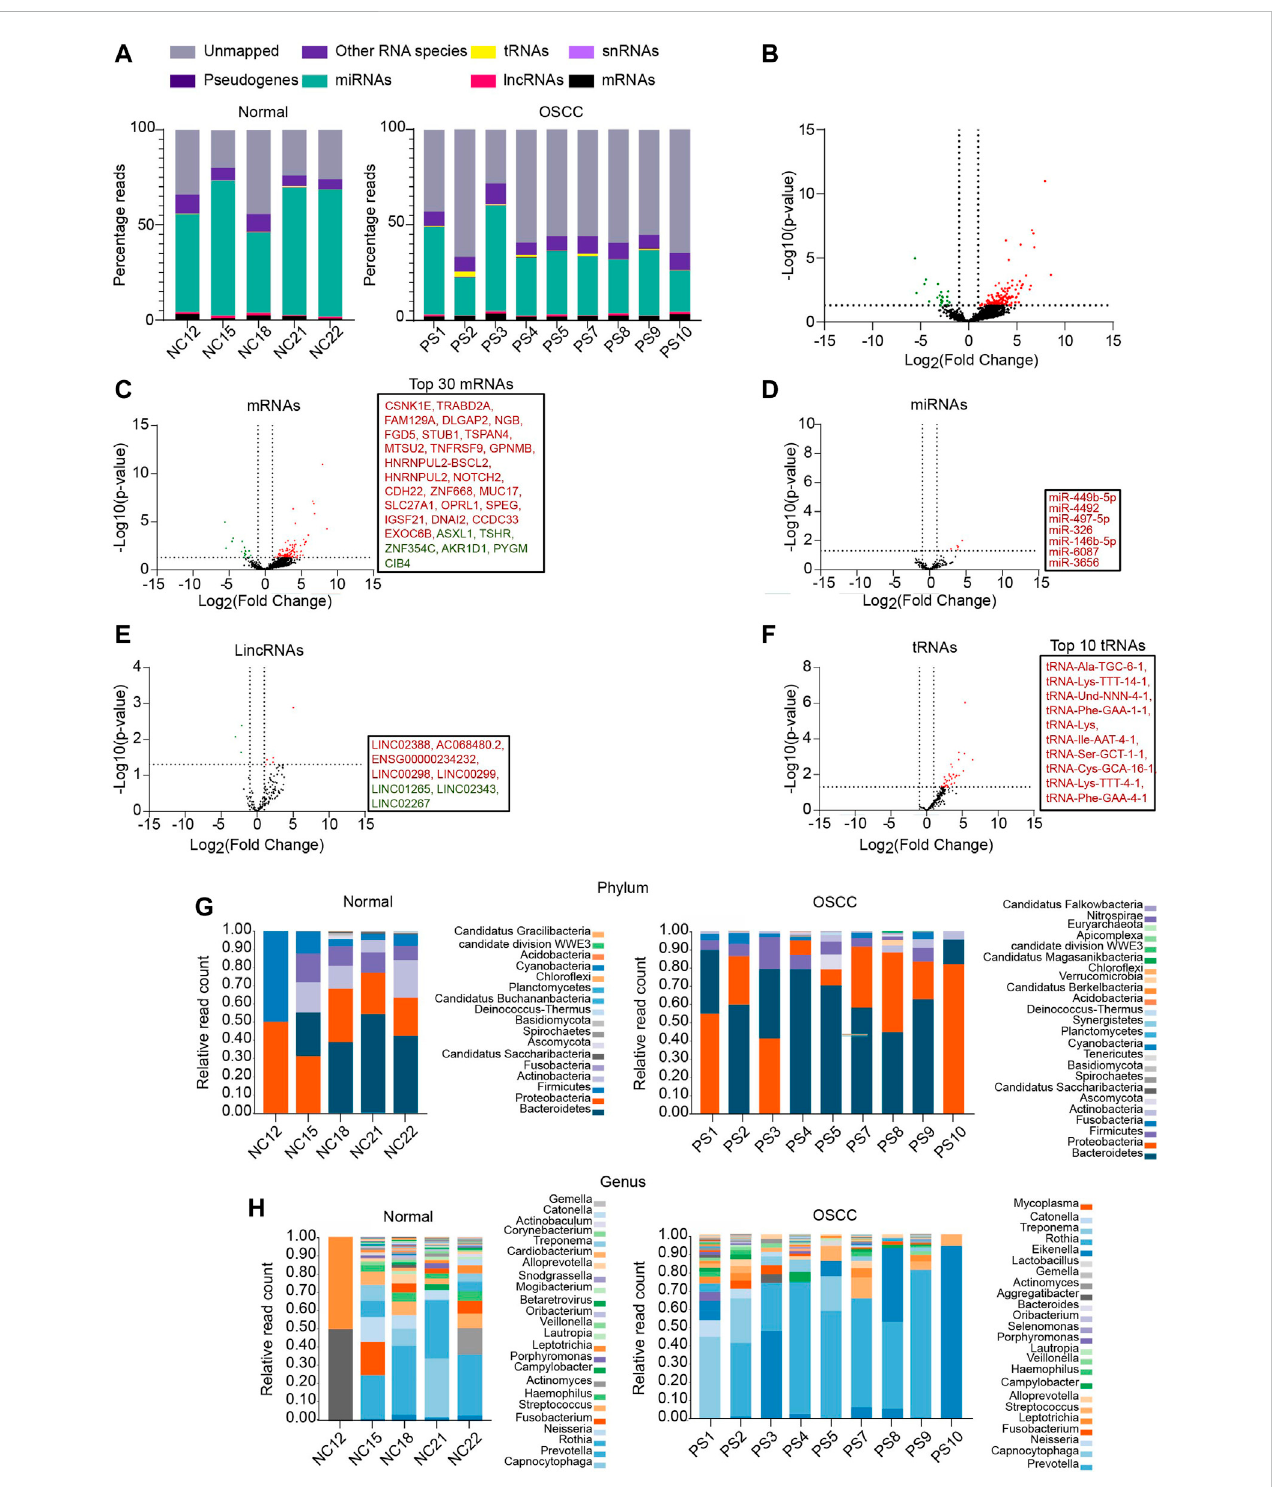
FIGURE 1 RNA pro fi ling of salivary samples. (A) Read distribution of host salivary RNAs among normal and OSCC. (B) Volcano plots representing total altered transcriptsinnormalandOSCC(log 2 foldchange ≥ 1or ≤ -1, p ≤ .05).VolcanoplotsshowingDEof (C) mRNAs, (D) miRNAs (E) lincRNAs, (F) tRNAs,respectively. Text boxes include names of top 30 mRNAs, all DE miRNAs, all DE lincRNAs, and top 10 tRNAs respectively. Relative read count of bacterial phyla (G) and genera (H) in normal and OSCC (cut off, ≥ 5 reads in at least 2 samples). NC = Normal control, PS = Patient